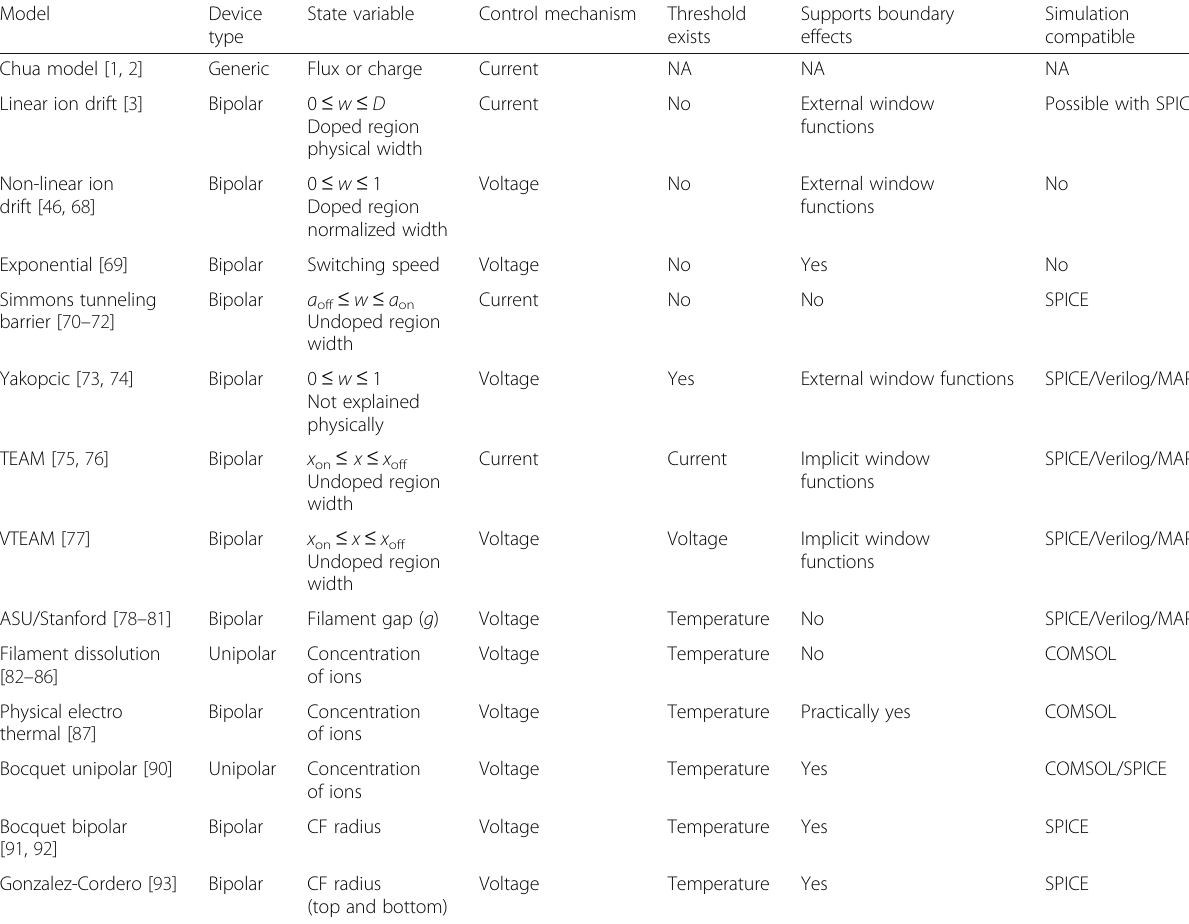
Table 1 Comparative analysis of the